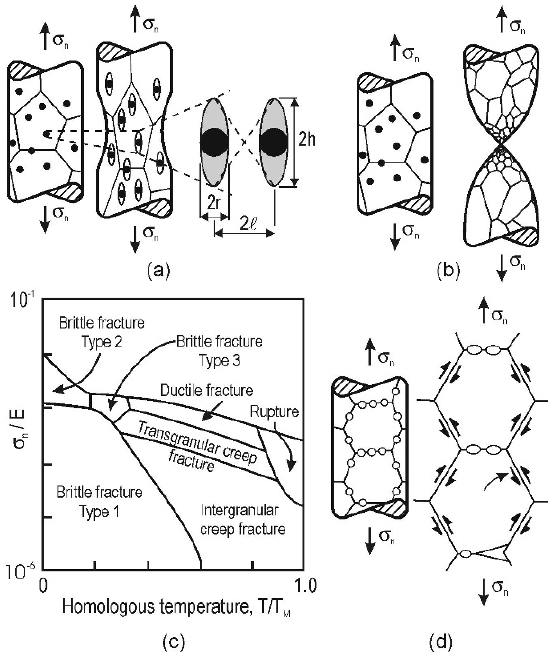
Figure 2. Mechanisms of brittle fracture: a) type 2, b) type 3, c) type 1, d) definition of the three type of brittle fracture. Based on [3–6].